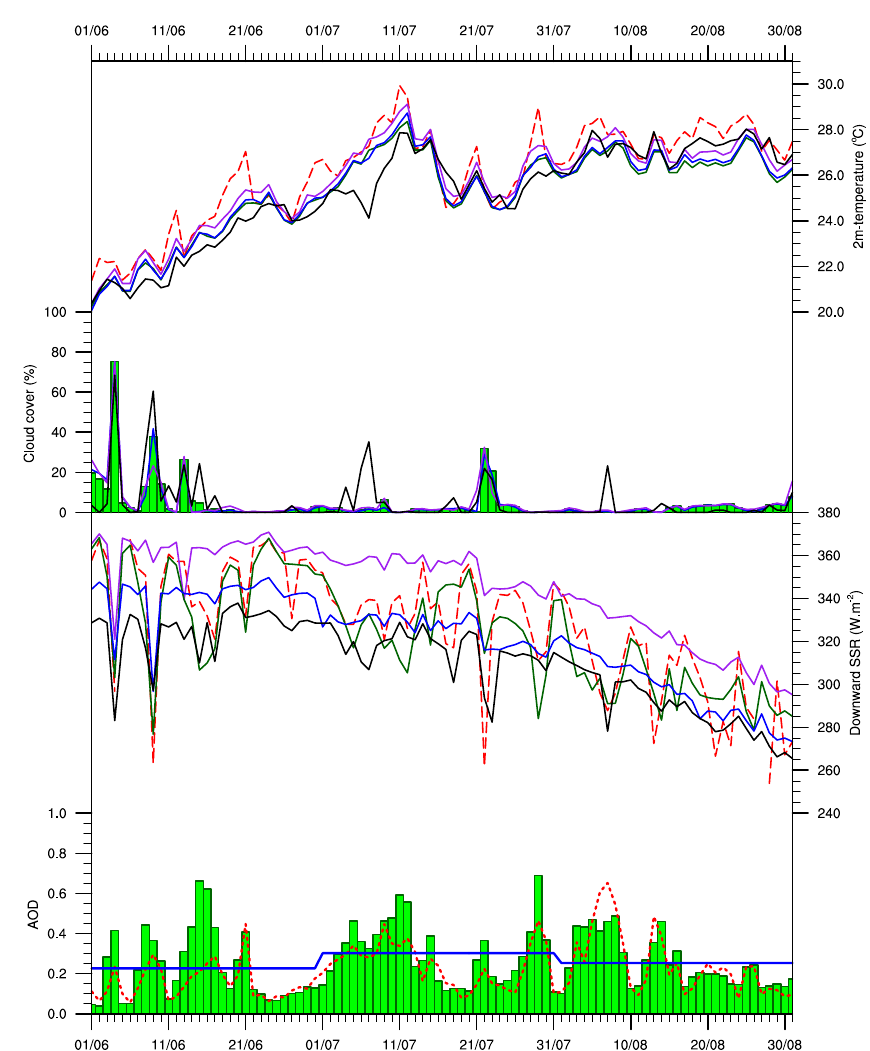
Figure 9. 2m temperature ( ◦ C, curves), cloud cover (%, green bars for PROG, curves for the other simulations), downward SSR (Wm − 2 , curves) and AOD (green bars for PROG, blue line for PROG-M), from top to bottom, in Lampedusa (Italy) for PROG (green), PROG-M (blue), NO (purple), ERA-Interim (black) and observations (dashed red).